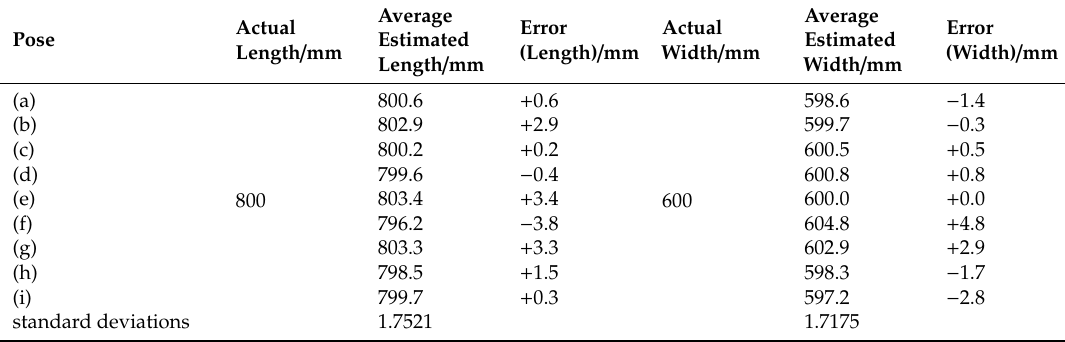
Table 3. Error analysis of the measurement results of nine di ff erent poses for 30